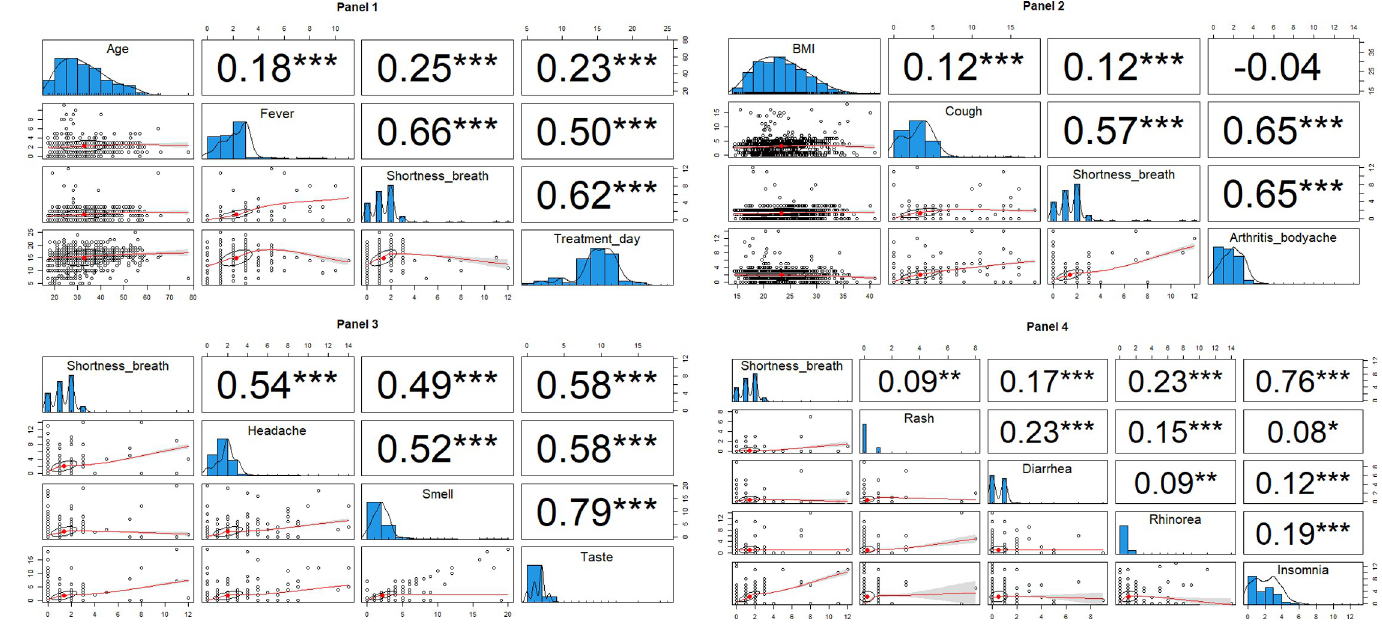
Fig 2. Correlation matrix for multicollinearity